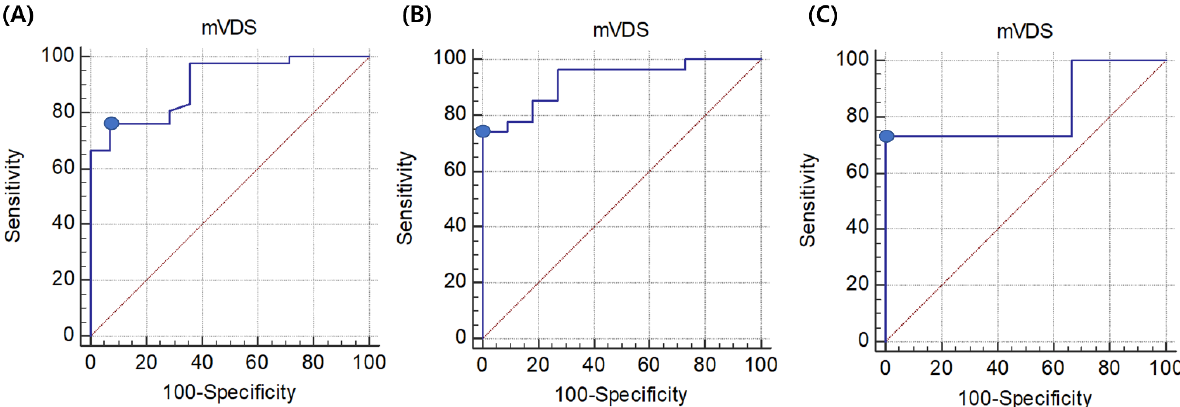
Figure 1. ( A ) ROC curve of the mVDS score for the selection of oral feeding in stroke patients with dysphagia. The optimal cut-off value (dots on the curves) of the mVDS score, which was obtained from the maximal Youden index, was ≤ 36.5 (AUC, 0.904; 95% CI, 0.795–0.966; p < 0.0001; sensitivity, 76.19%; specificity, 92.86%). ( B ) ROC curve of the mVDS score for the selection of oral feeding in supratentorial stroke patients with dysphagia. The optimal cut-off value obtained from the maximal Youden index was a score of ≤ 32 based on the mVDS (AUC, 0.926; 95% CI, 0.793–0.986; p < 0.0001; sensitivity, 74.07%; specificity, 100.0%) for the selection of oral feeding. ( C ) ROC curve of the mVDS score for the selection of oral feeding in infratentorial stroke patients with dysphagia. The optimal cut-off value obtained from the maximal Youden index was a score of ≤ 32 based on the mVDS (AUC, 0.822; 95% CI, 0.573–0.959; p = 0.0067; sensitivity, 73.33%; specificity, 100.0%) for the selection of oral feeding. ROC: receiver operating characteristic, AUC: area under the receiver operating characteristic curve, CI: confidence interval, mVDS: modified version of the Videofluoroscopic Dysphagia Scale.